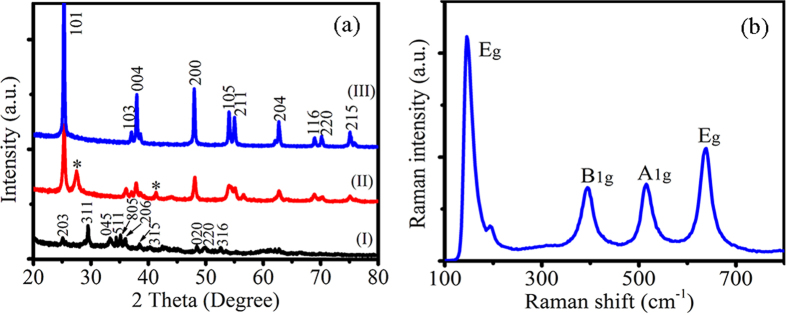
XRD powder patterns and Raman spectroscopy.(a) H-titanate nanowires corresponded well to H2Ti5O11·H2O phase (I), the obtained sample after the second-step hydrothermal reaction in pure water was indexed as mainly anatase TiO2 phase and few H2Ti8O17 phase and rutile TiO2 phase (II), the obtained sample in NH4F solution was indexed as pure anatase TiO2 phase (III). (b) Raman spectroscopy was taken to calculate the percentage of {001} facets as 34% by the peak intensity ratio of the Eg (at 144 cm−1) and A1g (at 514 cm−1) peaks.